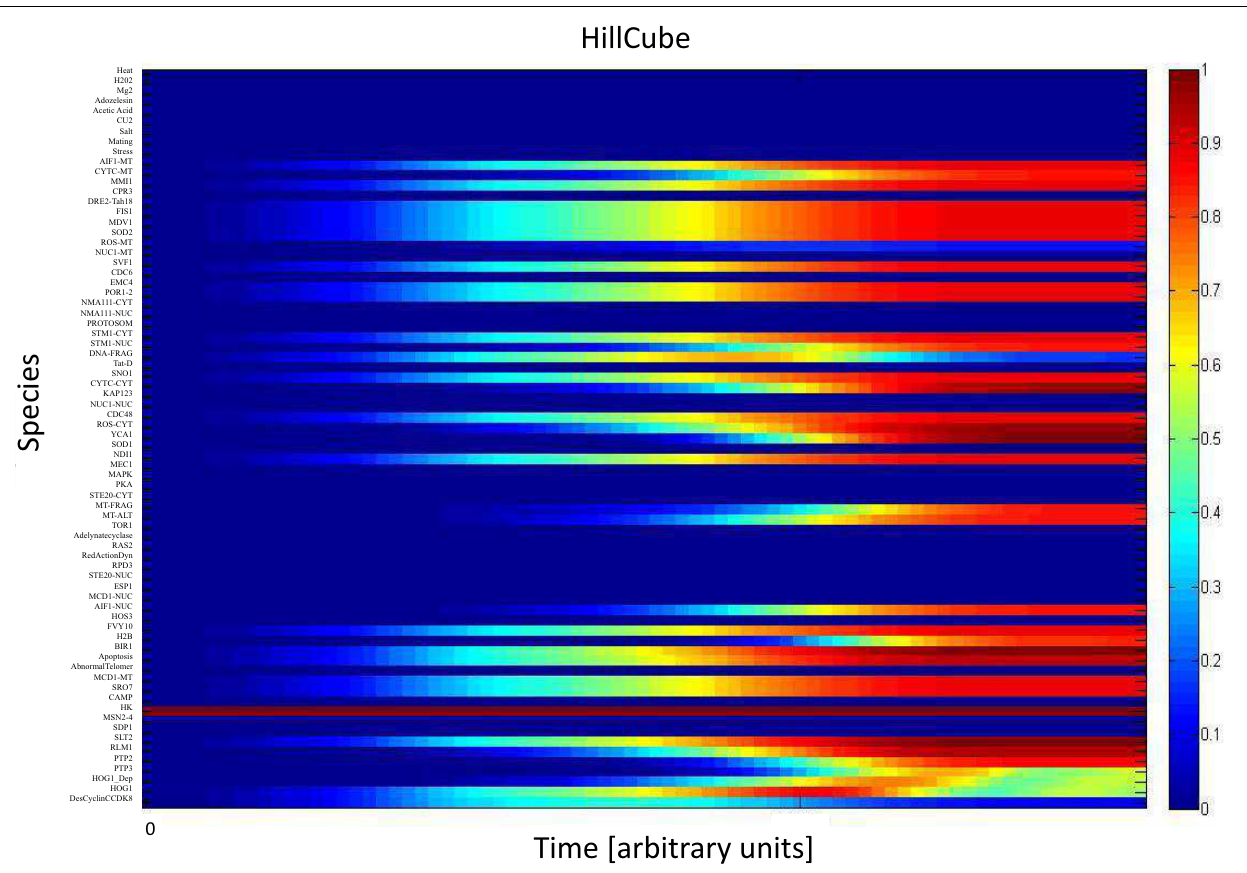
FIGURE 2 | Continuous Hill Cube transformation. All species in apoptosis network are mapped on vertical axis. Dark blue color indicates those nodes that are not activated (value = 0) while dark red refers to nodes which are completely activated (value = 1). Each color in between indicates the level of activation between 0 and